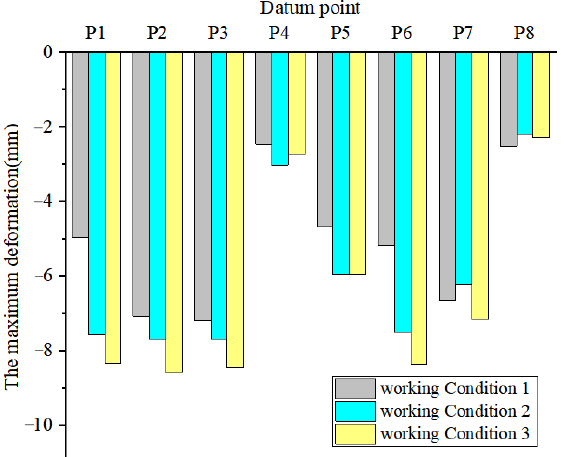
Figure 10. The maximum deformation of three working conditions.